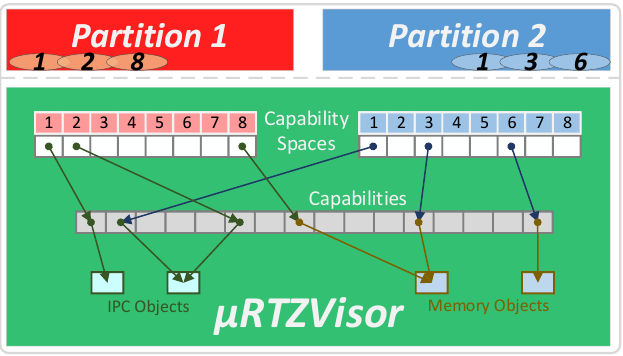
Figure 4. Capability-based access control system